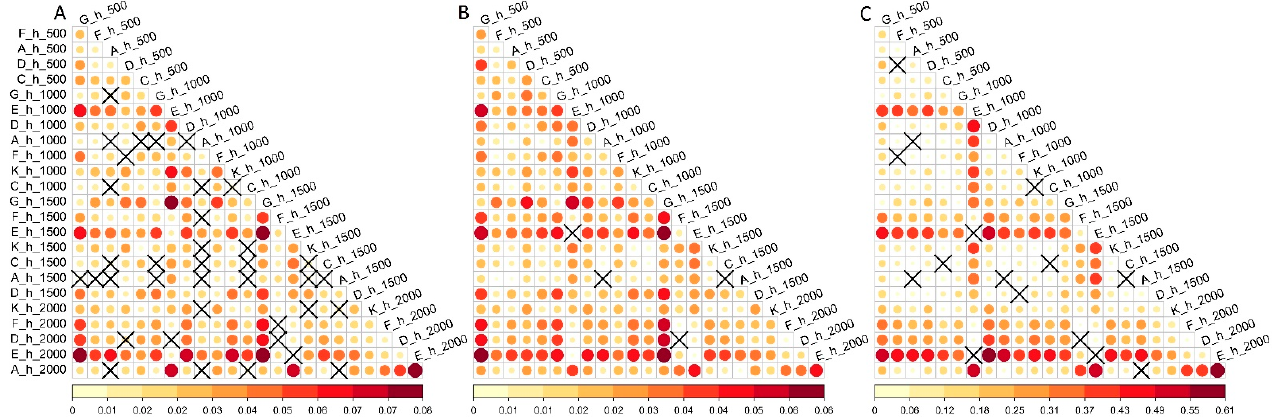
Figure 10. Pairwise F ST fixation indices calculated between 24 population samples based on 761 neu- tral SNPs ( A ), all 25,143 SNPs ( B ) and 550 adaptive SNPs ( C ). Significant values are highlighted by color ( p < 0.05), with the shade and size of the circles reflecting the magnitude. Cross marks depict insignificant values.